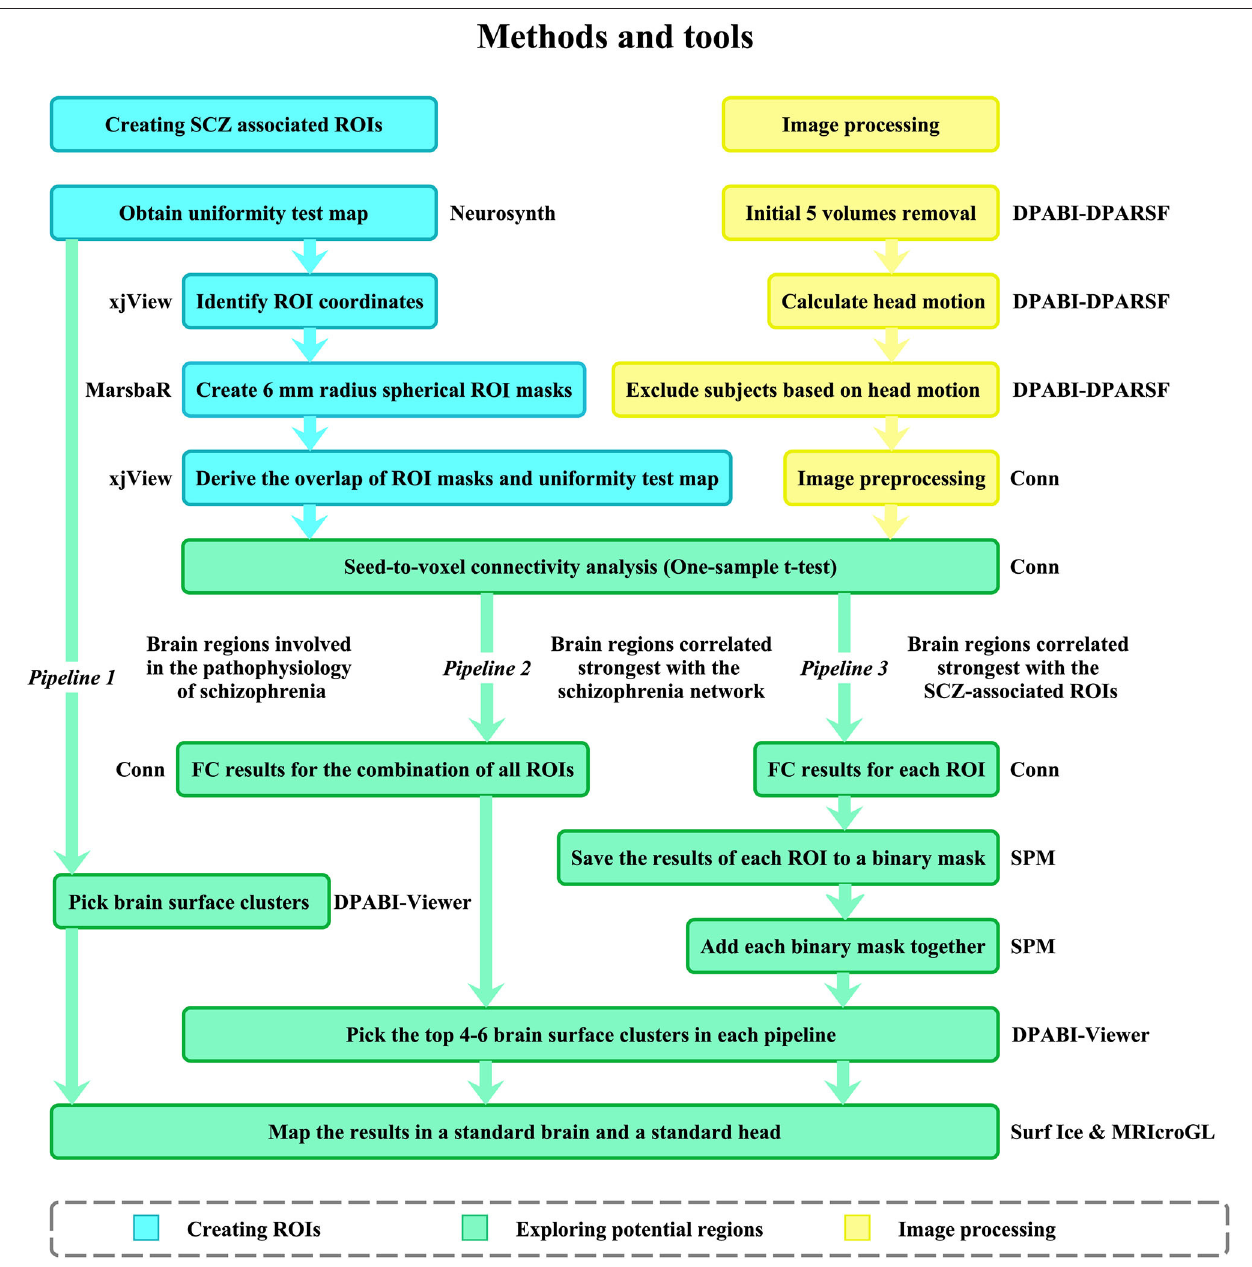
FIGURE 1 | Data processing procedure. SCZ associated ROIs were identified from meta-analysis conducted by Neurosynth. The ROIs were used for FC analysis in 32 SCZ patients. Then, three pipelines were applied to explore potential targets for NIBS in SCZ. ROI, region of interest; FC, functional connectivity; RMS, root mean square; SCZ,